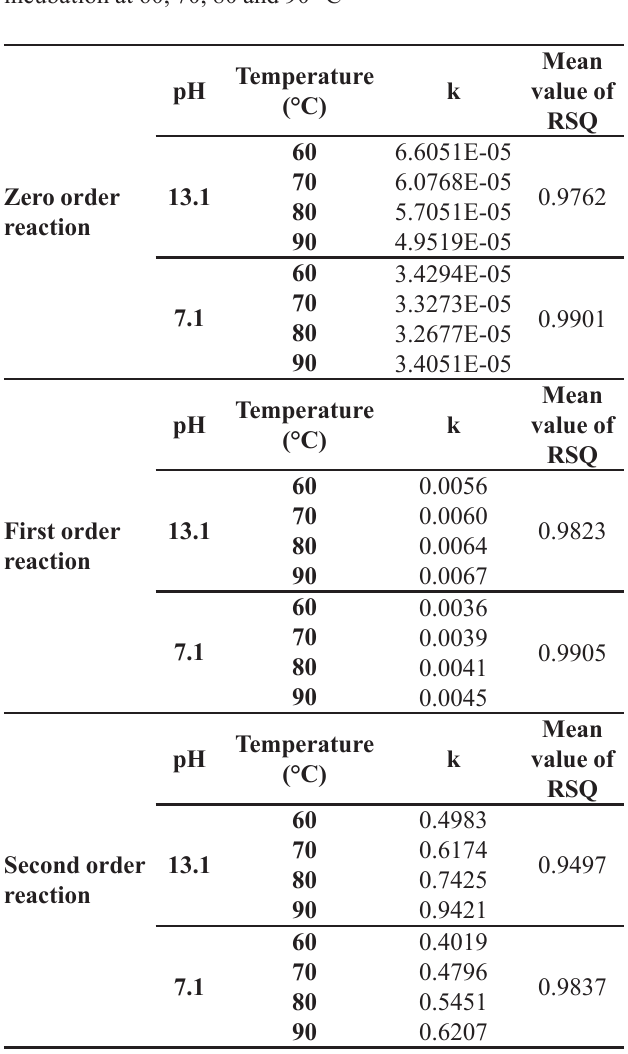
FIGURE 3 - The first order reaction plot of HCTZ-lactose liquid mixture at pH=7.1 after 30, 60, 90 and 120 minutes incubation at 60, 70, 80 and 90 °C. TABLE I - The values of reaction rate constants (k) and RSQ obtained from the order reaction plots of HCTZ-lactose liquid mixture at pH=13.1 and 7.1 after 30, 60, 90 and 120